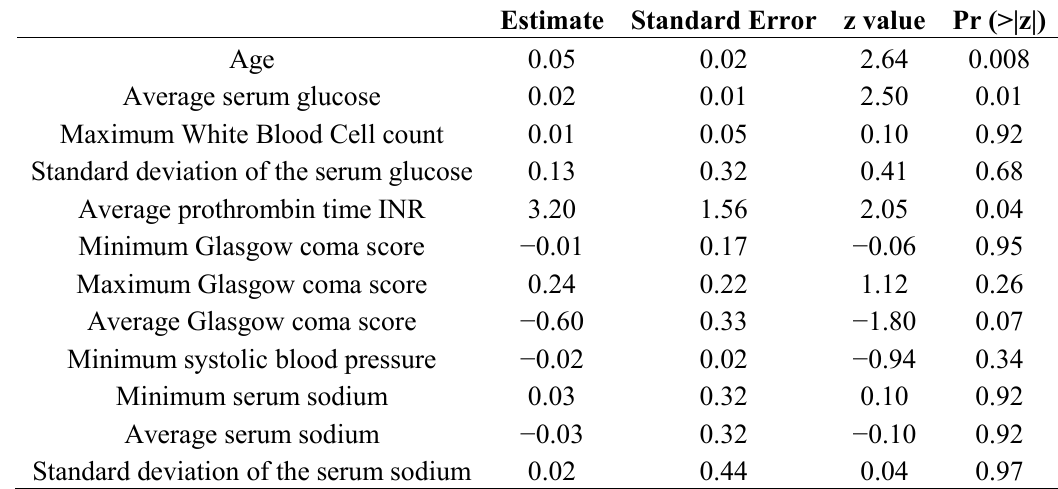
Table 4. Best fitted logistic regression model for ICU patients who presented with